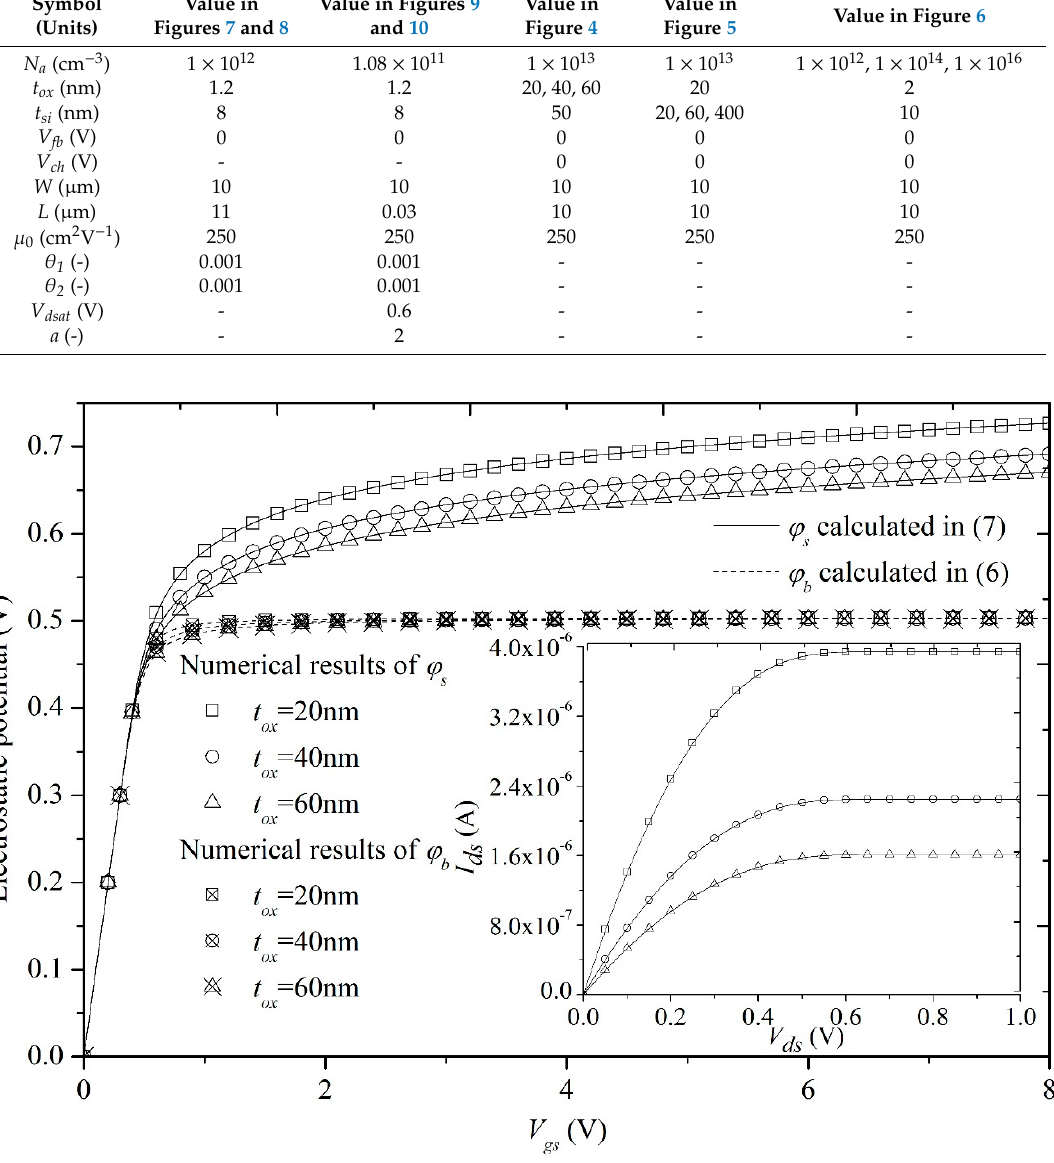
Table 1. Parameters for simulations in Figures 4–10.